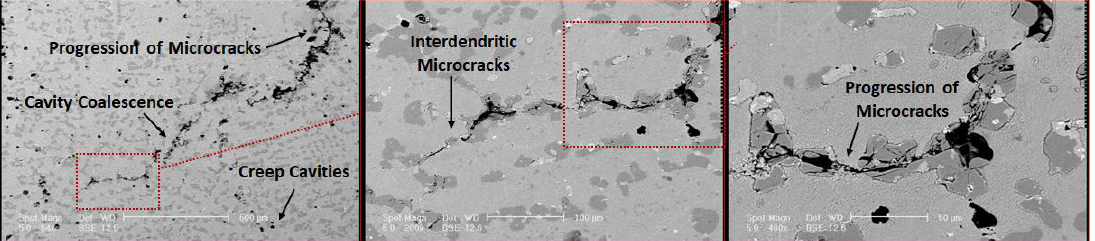
Figure 9. SEM images showing the pile-up of creep pores along the length of grain boundaries or inside grain boundary carbide particles and coalescence for the formation of cracks in the failed tube.